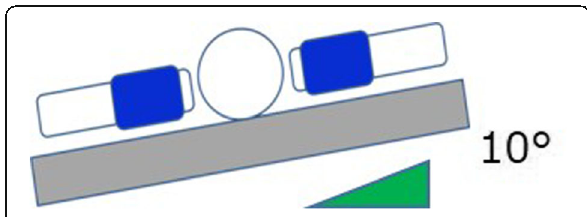
Fig. 2 Image depicting left uterine displacement (about 10°) to prevent